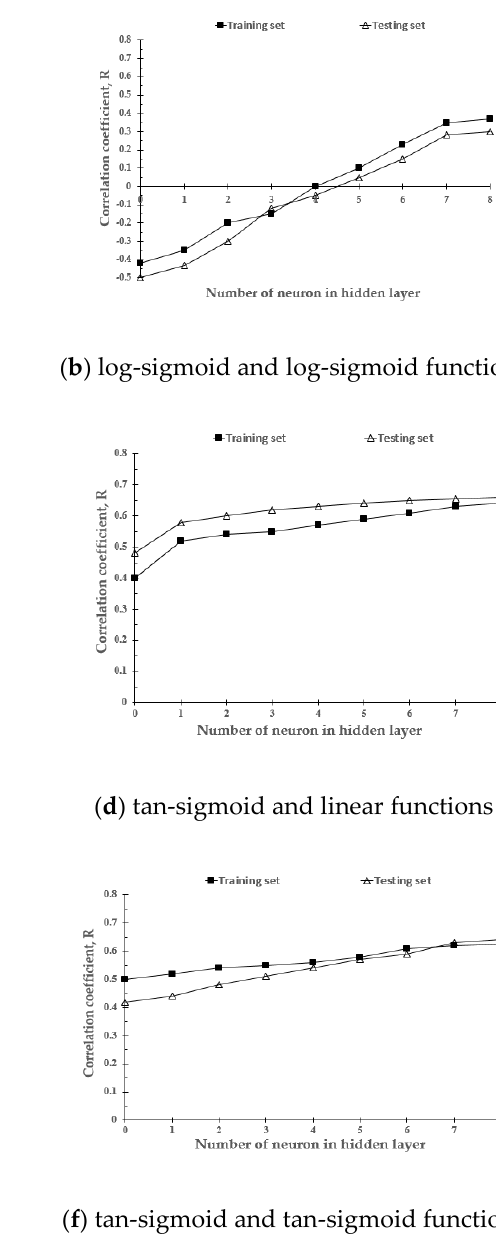
Figure 7. Correlation coe ffi cients of training and testing sets: ( a ) log-sigmoid and linear functions, ( b ) log-sigmoid and log-sigmoid functions, ( c ) log-sigmoid and tan-sigmoid functions, ( d ) tan-sigmoid and linear functions, ( e ) tan-sigmoid and log-sigmoid functions, and ( f ) tan-sigmoid and tan-sigmoid functions.